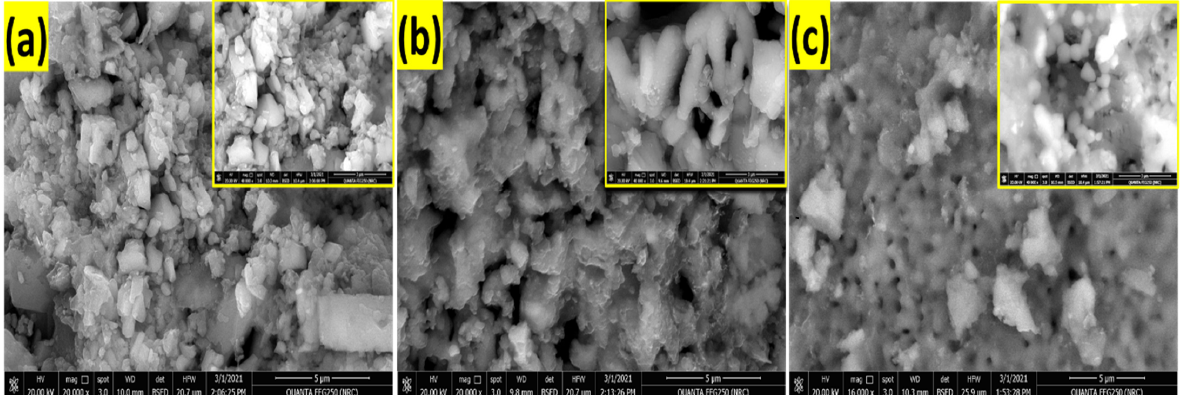
Figure 4. SEM images of top view for RW nanostructured; ( a ) RW mix , ( b ) RW 0.03 and ( c ) RW >0.3 . The insets show magnified SEM images.